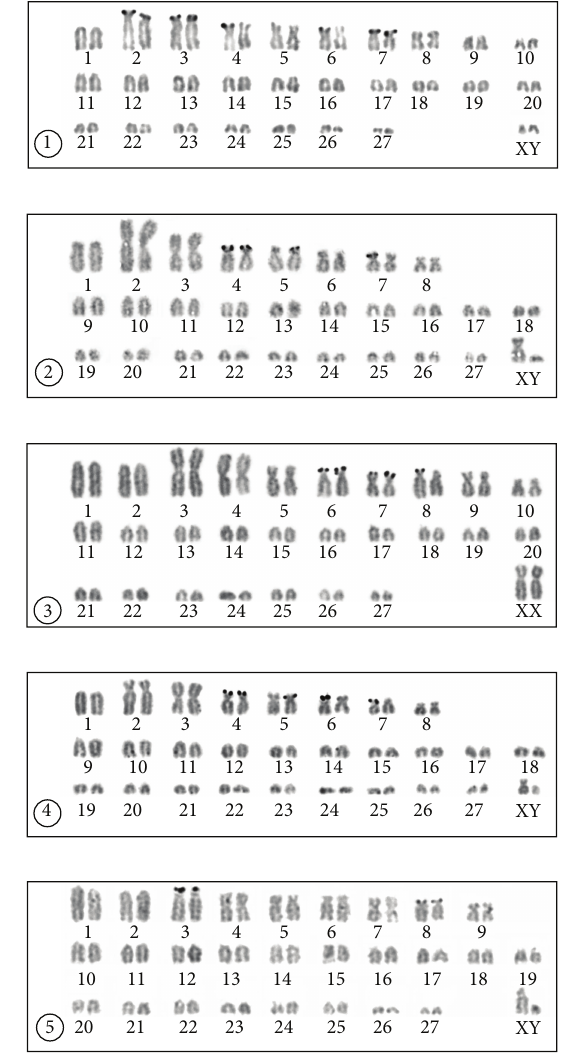
Figure 3: C-banded karyotypes of specimens of Nannospalax leu- codon from Babaeski (1) and N. xanthodon from Kula (2), Alas¸ehir (3), Yılanlı (4), and G¨ulek (5).